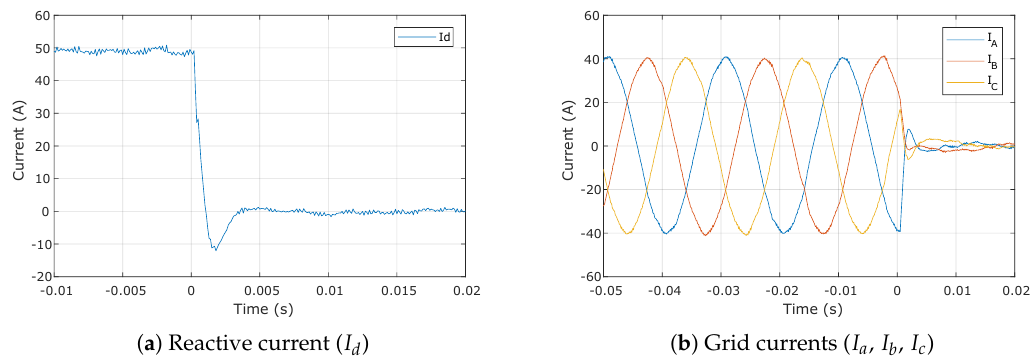
Figure 14. Experimental results for a system with a delay of three samples and the model-based prediction. In our experimental setup, the control balances the cell voltages employing the sorting algorithm. For this, it receives from each cell its voltage, organizes the cells in ascending order, and selects the ones with the highest or lowest voltages depending on the arm current polarity. When the converter control has an internal network, the capacitor voltage will reach the central controller after the delay introduced by the network. We have tested the scenario without any delay and emulated a network that delays the capacitor voltages by two samples. Figure 15 shows the measured capacitor voltages from one arm of our experimental converter, where we see that the delay of only two samples does not influence the